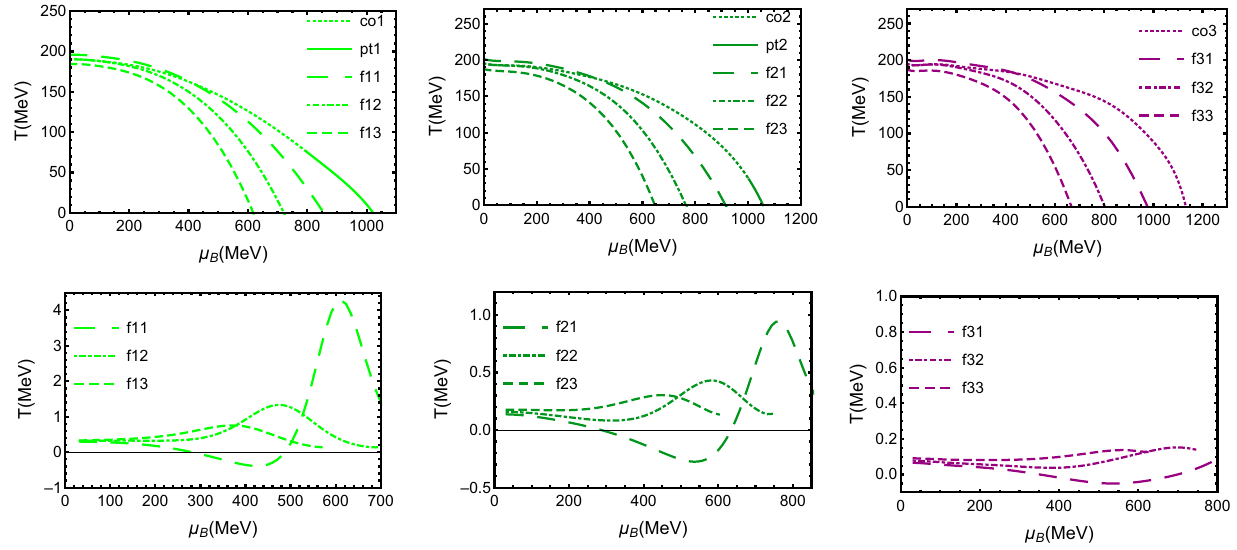
Fig. 3 (Above) The chiral phase transition line in the NJL model with the 1st order phase transition line and the crossover indicated by solid and dotted lines, respectively. Three different freeze-out lines for each model NJL-I (with I = 1, 2, 3) are defined in Eq. (18): (1) fI1 starts from the back ridge of the chiral phase boundary, goes through the negative region and then cross the phase boundary; (2) fI2 starts from the chiral